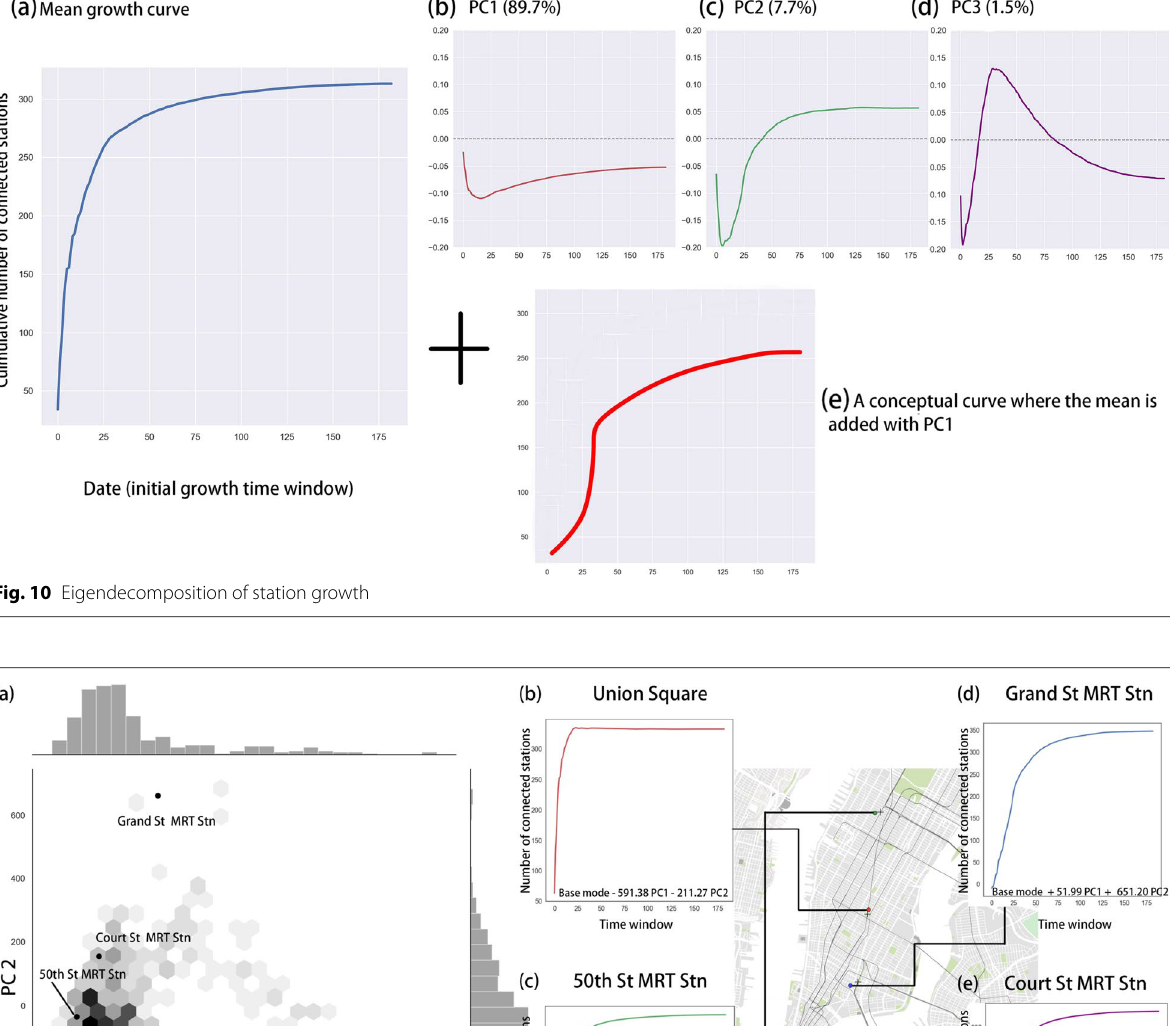
Fig. 11 a Joint distribution of the coefficients of PC 1 and 2 of all stations and b – e temporal growth curves reconstructed from the two